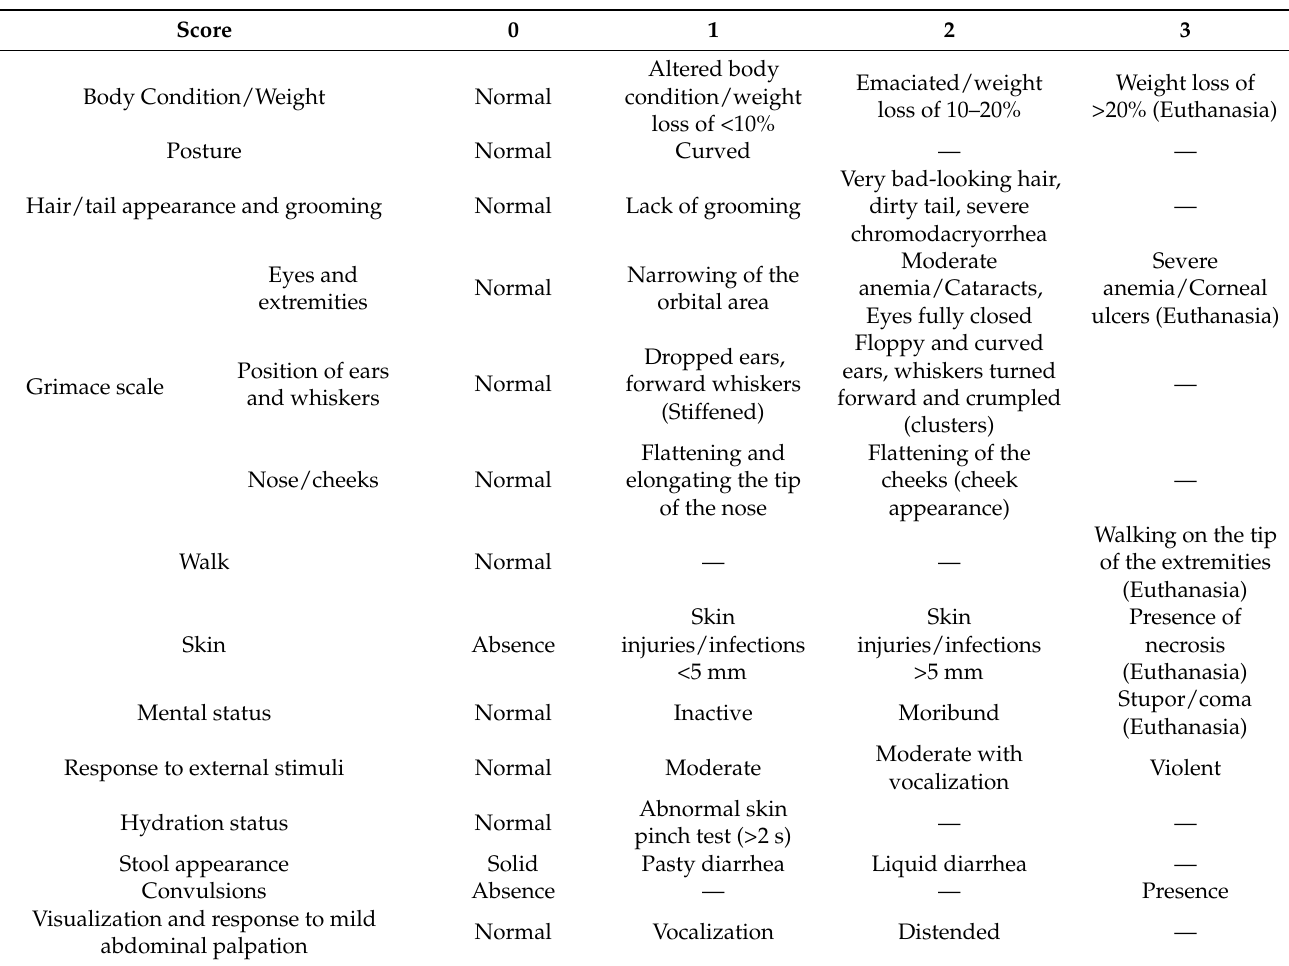
Table 1. Humane endpoints applied to the rat model of chemically induced type 2 diabetes. Adapted from Silva-Reis et al., Faustino-Rocha et al. and CCAC guidelines